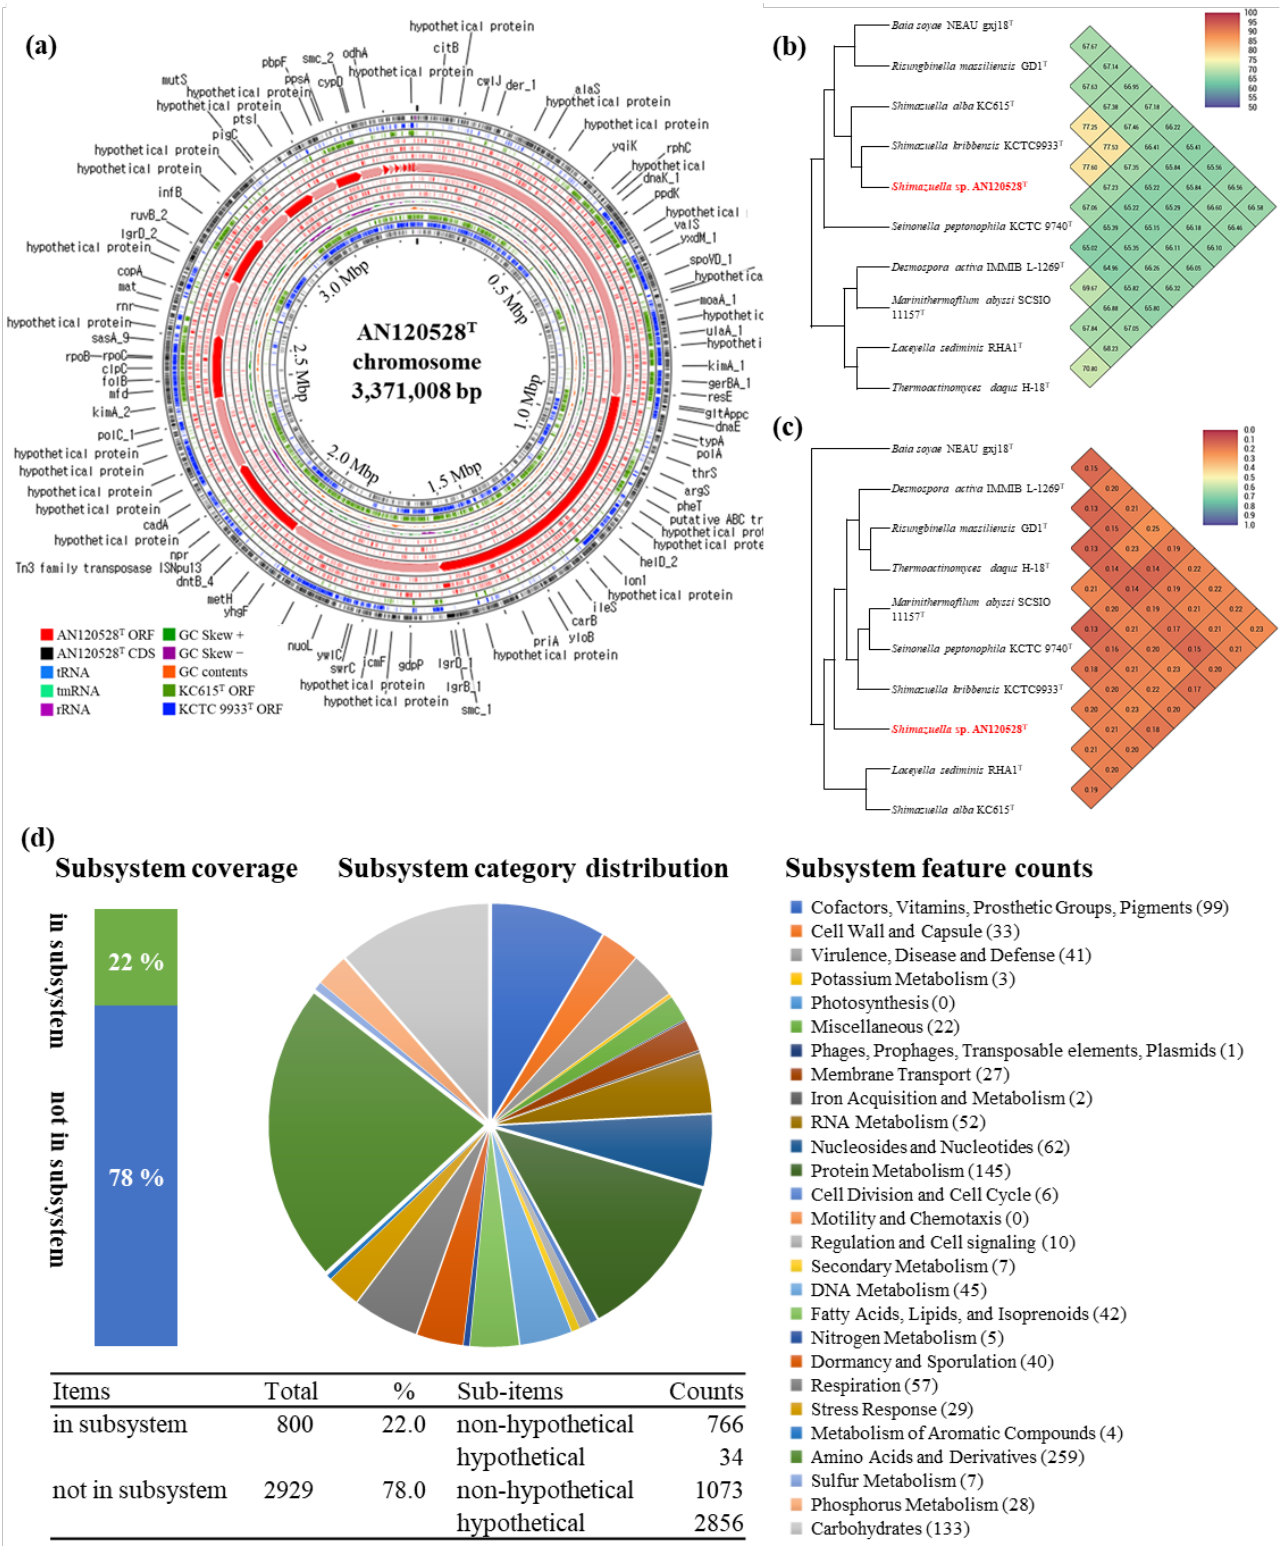
Figure 3. Graphic representation of genomic features of AN120528 T . ( a ) Circular plot of the compar- ison genomes of AN120528 T , KC615 T and KCTC 9933 T . ( b ) OrthoANI analysis with other related strains. ( c ) GGDC analysis. ( d ) Genome annotation results of AN120528 T on the RAST webserver.